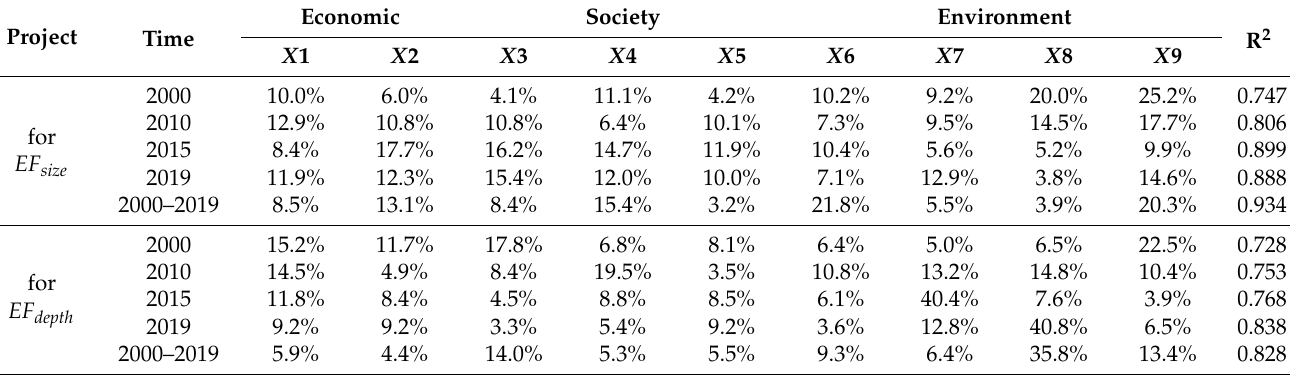
Table 6. The importance ratio and model performance of indicators in each